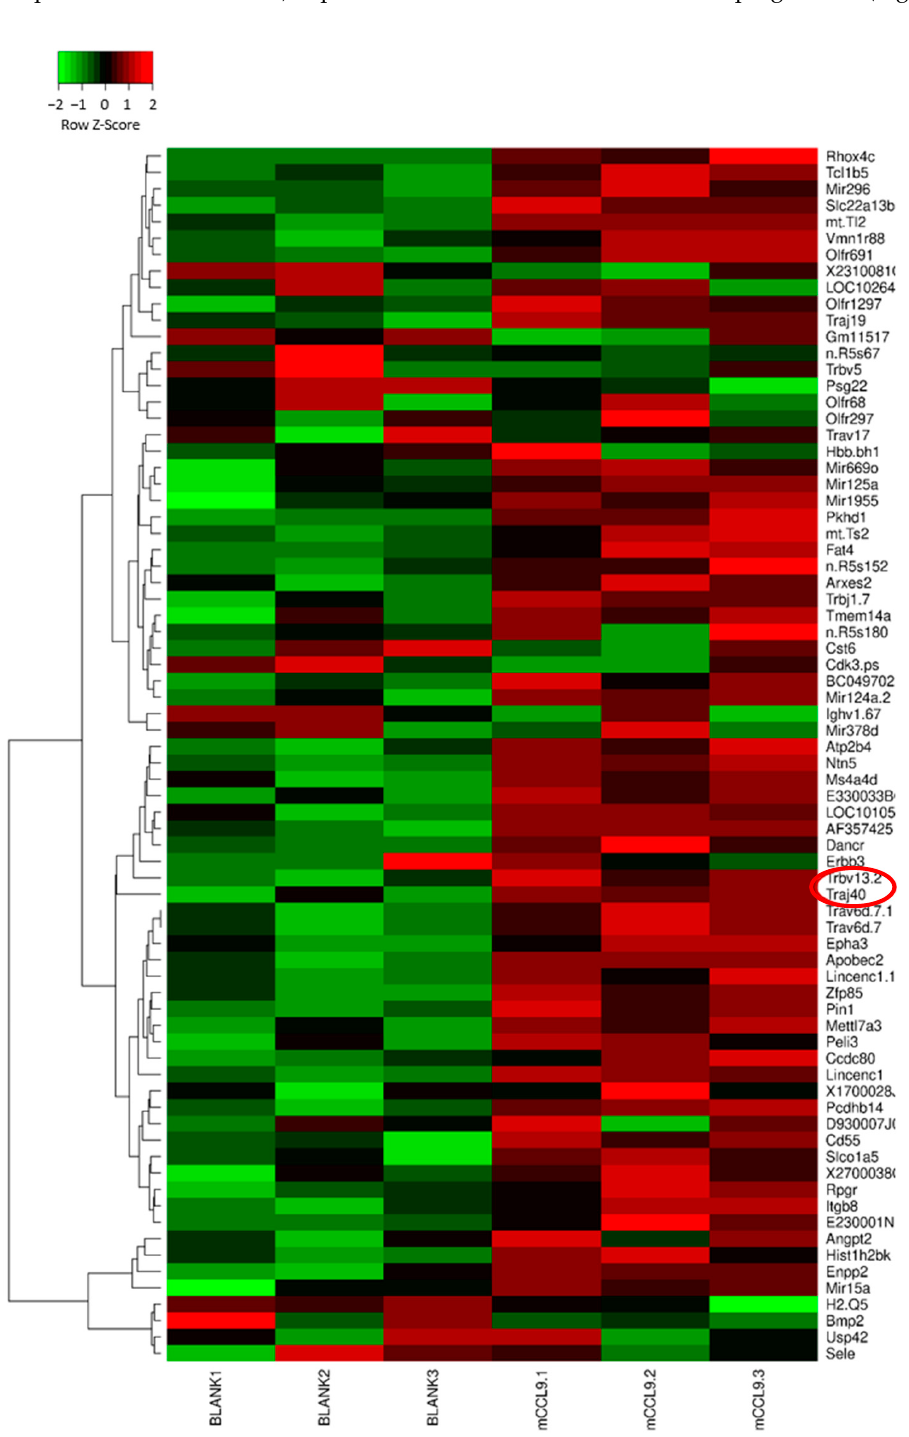
Figure 7. Heatmap with up- or downregulated genes in collected tumors. Di ff erences in values be- tween control and mCCL9+ groups were assessed by t -test, where p < 0.05 was considered statisti- cally signi fi cant.